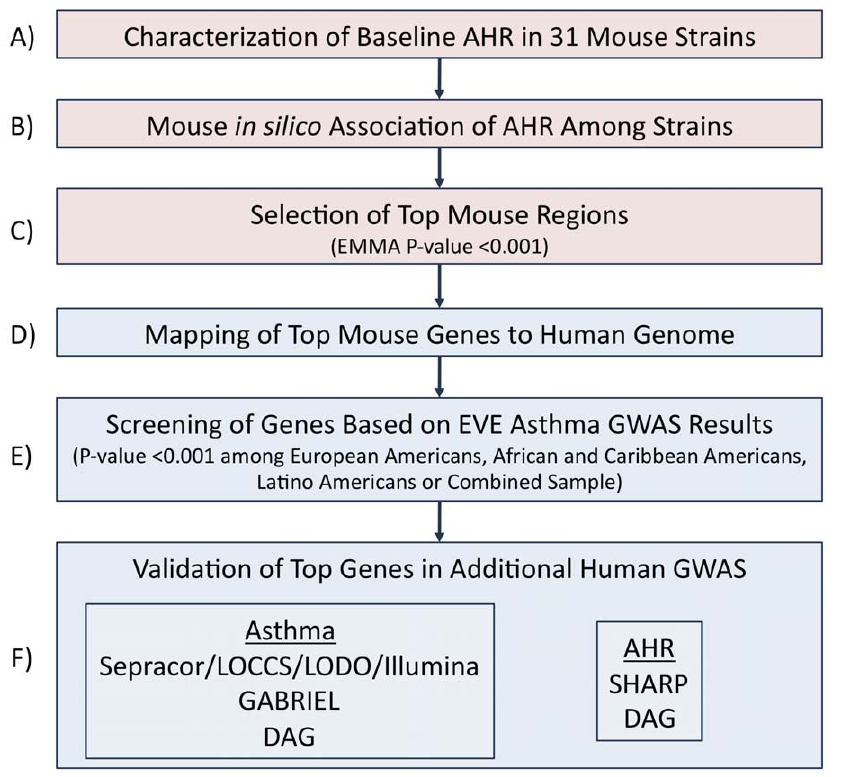
Figure 1. Study overview. Mouse association study (in pink): (A) Baseline AHR slope measures were obtained for 31 mouse strains, and these were (B) used to perform an association study using EMMA software. (C) Mouse genes near or containing SNPs with p-values , 0.001 were selected for follow-up study in human GWAS datasets. Integration of mouse results with human data (in blue): (D) HomoloGene maps were used to obtain human homologous genes corresponding to the top mouse genes. (E) Genes with SNPs having p-values , 0.001 in the combined EVE meta-analysis or within race/ethnic specific GWAS were selected for (F) replication in other human GWAS.